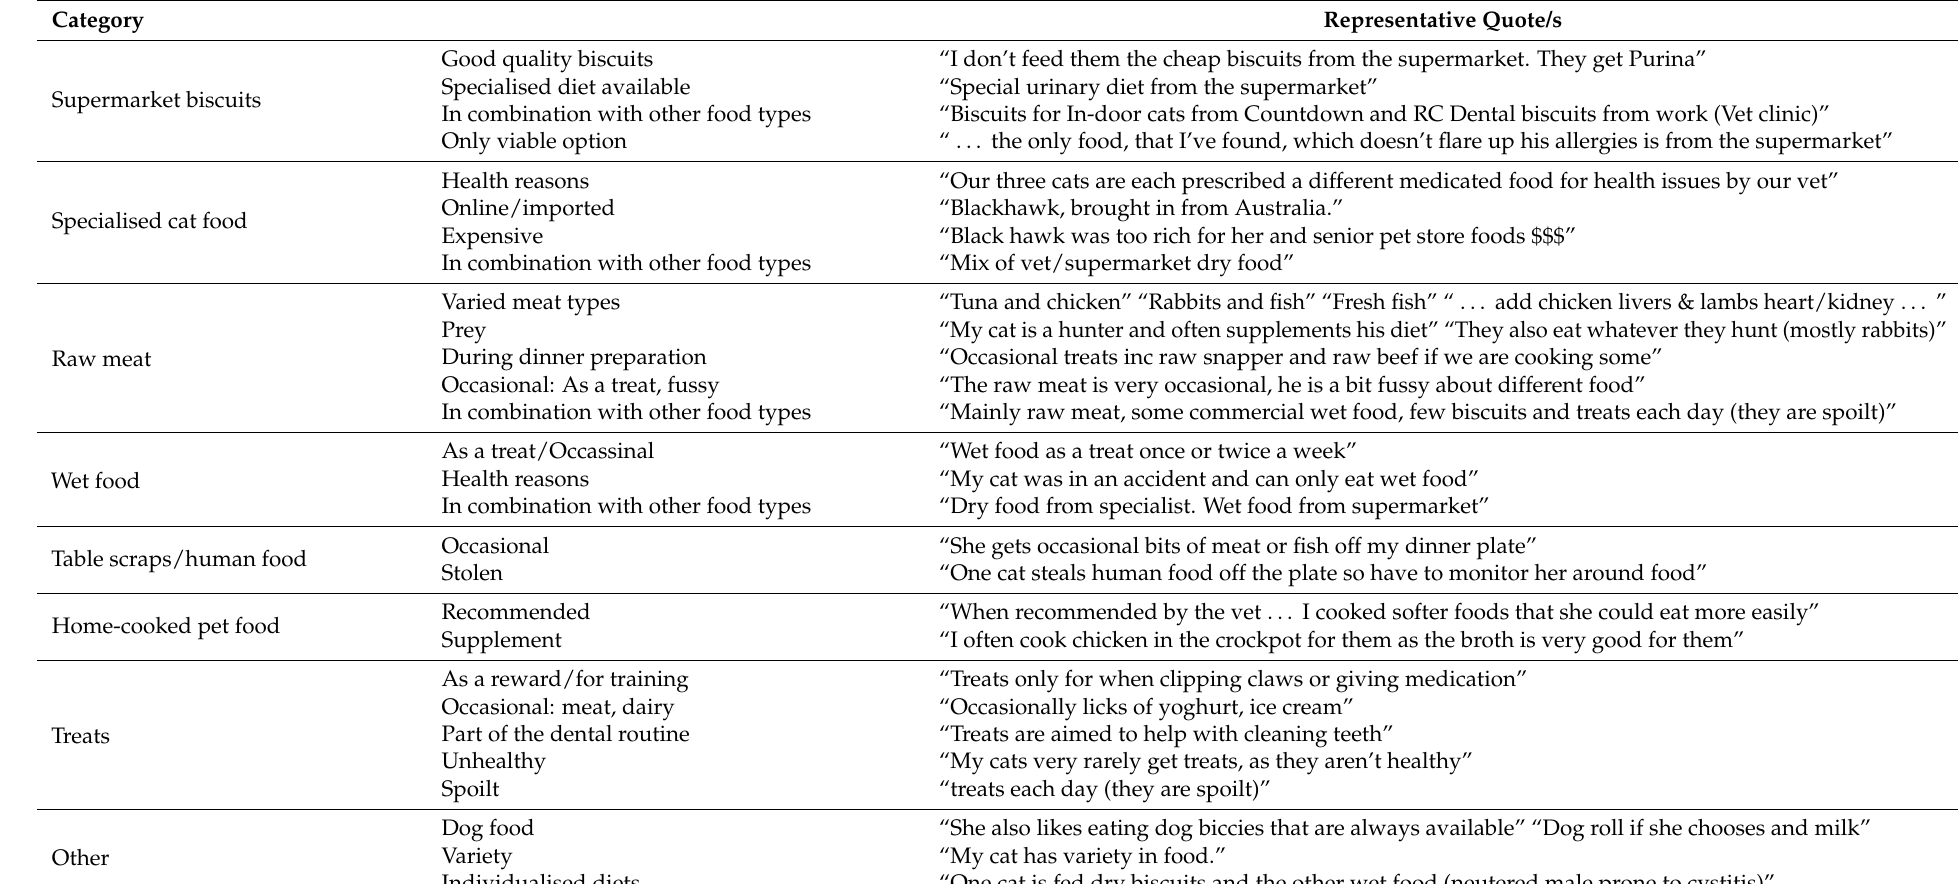
Table 2. Thematic analysis of comments provided about respondents’ cat diets in the 2019 New Zealand Pet